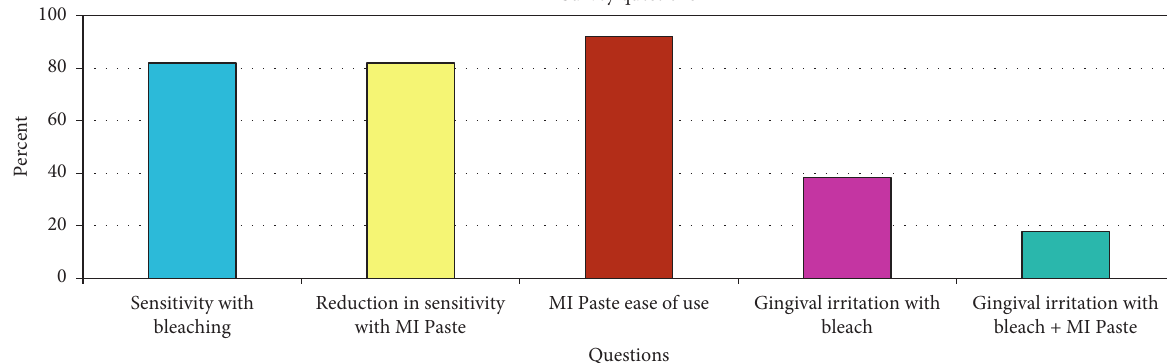
Figure 4: Survey